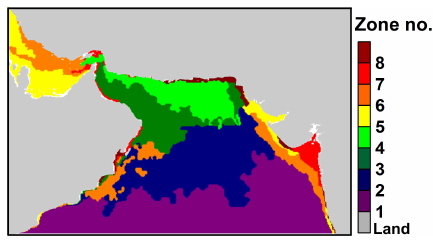
Figure 3. The identified ecological zones obtained from the combi- nation of 4 PCs and 8